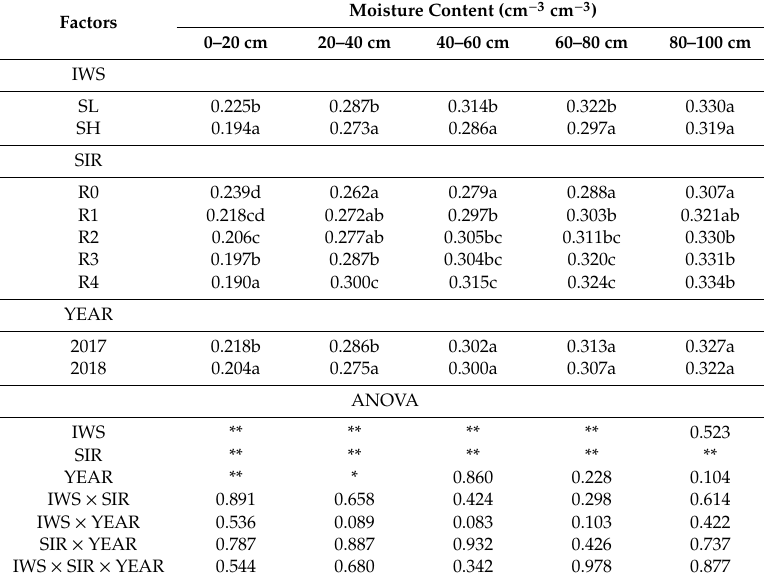
Table 4. Mean values of moisture content in the 0–100 cm soil profile, and results of the three-way ANOVA with irrigation water salinity (IWS), straw incorporation rates (SIR), and growing season (YEAR) as factors.